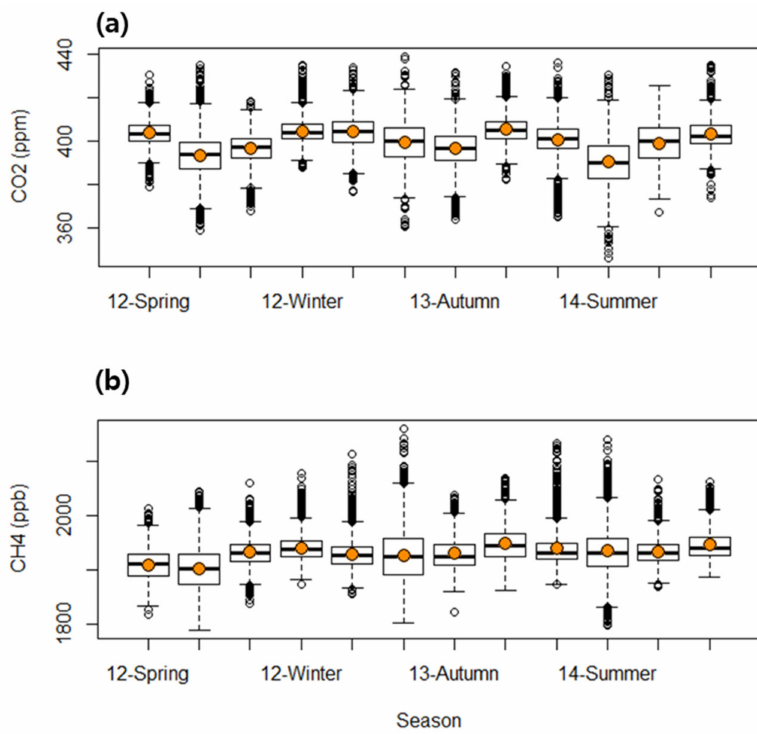
Figure 3. Seasonal variations of the measured ( a ) CO 2 and ( b ) CH 4 concentration in the GS station. The boxes represent the range between the 25th and 75th percentile of the measured values at GS. The line and circle components in boxes indicate the median and mean values, respectively. The whiskers indicate the highest (1.5 × IQR (the interquartile range) of the upper quartile) and lowest (1.5 × IQR of the lower quartile) values.